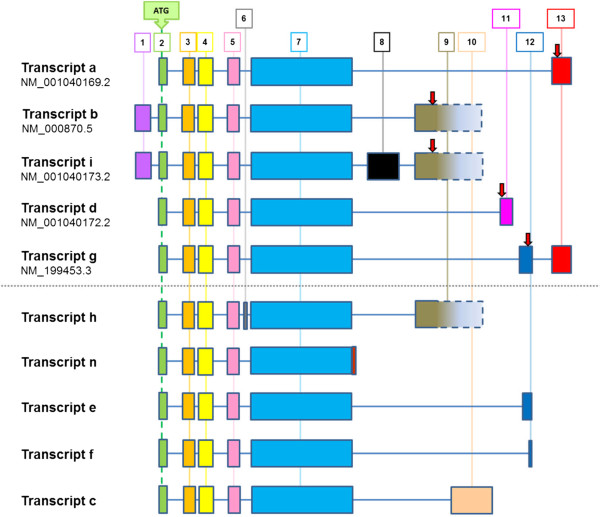
Known HTR4 transcript variants. Transcripts a, b, i, d and g are currently reported by NCBI (December 2012); translational stop positions are indicated by red arrows. Transcripts h, n, e, f and c have been described in the literature [11,15,30-32].